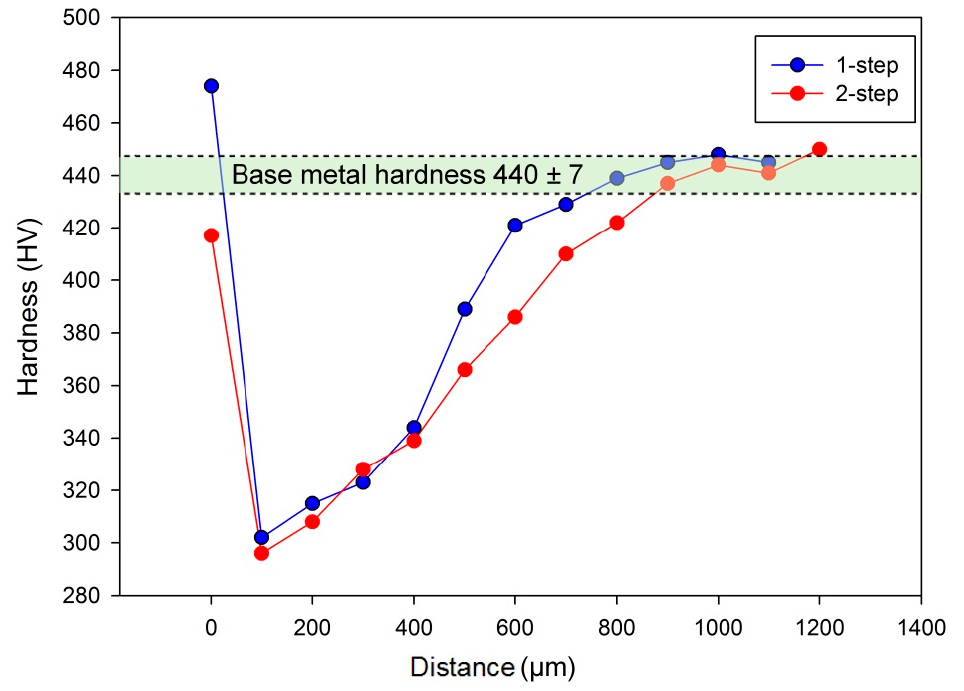
Figure 10. Hardness distribution of the SCHAZ at 6.0 kA in the one-step and the two-step RSW. For the PMZ, the properties and dimensions are greatly influenced by the welding